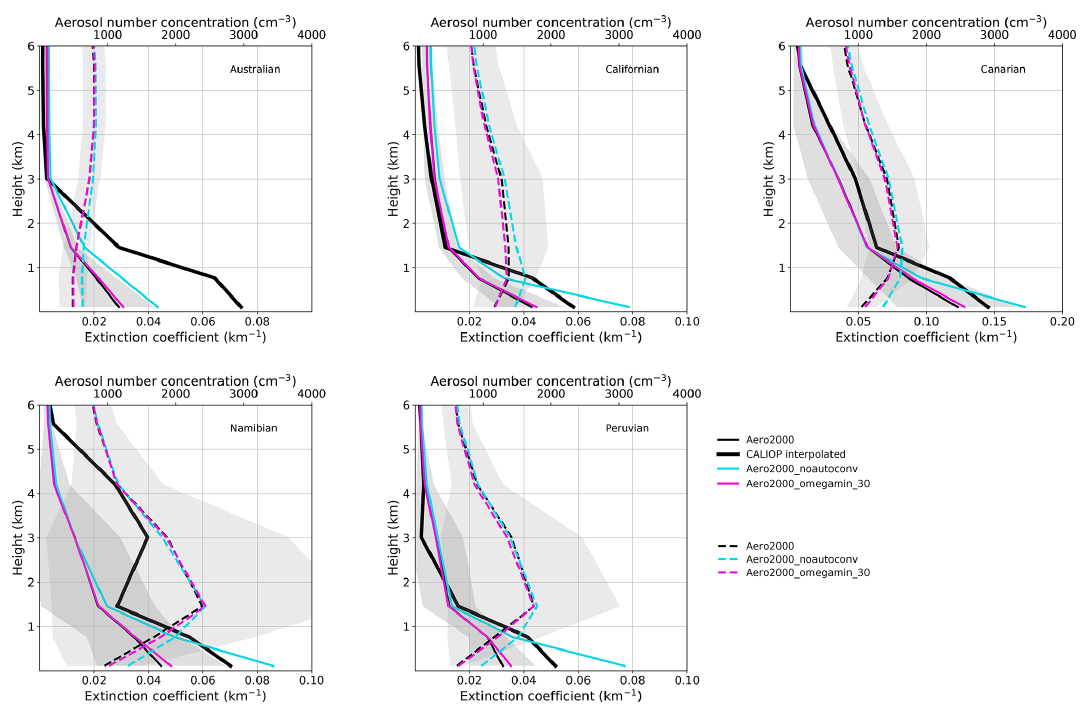
Figure 9. Vertical distribution of the aerosol extinction coefficient (km − 1 ; solid line) and aerosol number concentration (cm − 3 ; dashed line) for the Australian, Californian, Canarian, Namibian, and Peruvian regions for the model control simulation and sensitivity experiments in the category microphysics. The SD of the model control simulation is indicated as a grey shaded